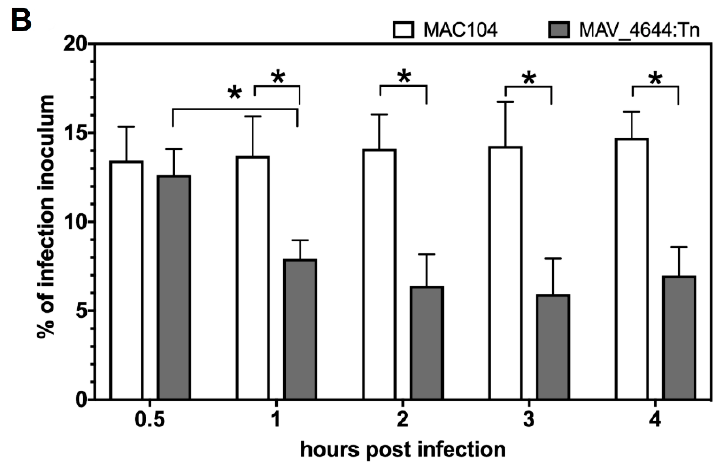
Figure 6. ( A ) The percentage of invasion of the wild-type MAC104 and MAV_4644:Tn clone. RAW264.7 cells were cultured in DMEM supplemented with 10% FBS in 24-well plates and infected with either the wild-type MAC104 or MAV_4644:Tn mutant for 2 h at 37 ◦ C and 5% CO 2 . The cells were washed twice with HBSS, incubated for an additional 2 h in culture medium supplemented 200 µ g / mL of gentamicin, and then lysed with 0.1% Triton X-100. The present of uptake was calculated by dividing cfu / mL at time 0 to the initial inoculum and multiplying by 100. The Student’s t -test was used to determine p -values as reported. ( B ) The percentage of MAC104 (white bars) and MAV_4644:Tn (grey bars) survival within 4 h of THP-1 macrophages infection. THP-1 macrophages were cultured in 48-well plates as describe above, and then infected with MAC104 or MAV_4644:Tn at an MOI of 10 for 30 min at 37 ◦ C and 5% CO 2 . All monolayers were washed twice with HBSS and selected wells were lysed at 30 min for time 0, while RPMI-1640 supplemented with 10% FBS was replaced in the rest of the wells for subsequent time points. Cells were lysed with 0.1% Triton X-100, serially diluted, plated on 7H10 agar plates and CFU counts were recorded. Survival of the wild-type versus mutant was analyzed using Student’s t test. *, p < 0.05 was determined significant.